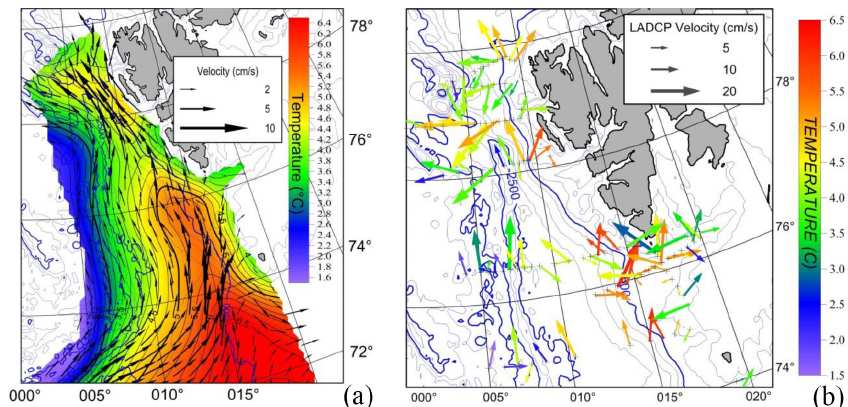
Fig. 19. Summer 2007. (a) Baroclinic currents and temperature at 100dbar and (b) LADCP-measured currents at